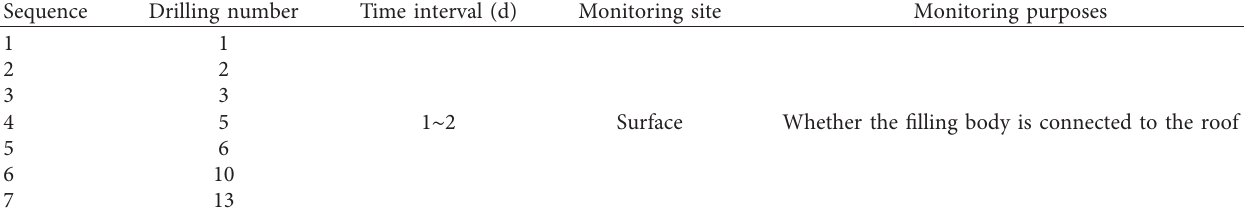
Table 3: Drilling measurement schemes.